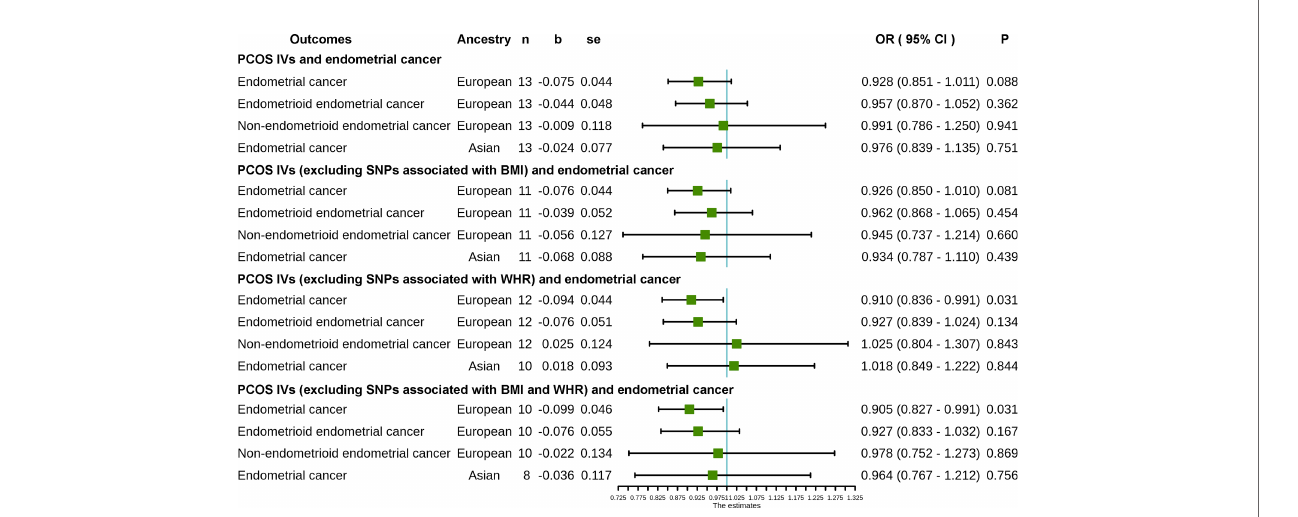
FIGURE 1 | Causal effect estimates of PCOS on endometrial cancer: the inverse-variance weighted (IVW) method was applied as the primary method for MR analysis. Abbreviations: PCOS, polycystic ovary syndrome; IVS, instrumental variables; SNP, single nucleotide polymorphism; n, number (number of SNPs included in the analysis); b, beta coef fi cient; se, standard error; OR, odds ratio; CI, con fi dence interval; BMI, body mass index; WHR, waist-to-hip